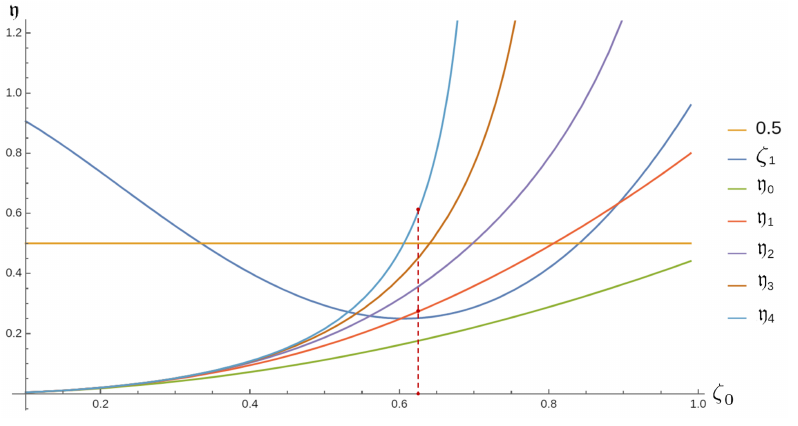
Figure 3. Comparison of the two criteria y m > σ 1 and y m >